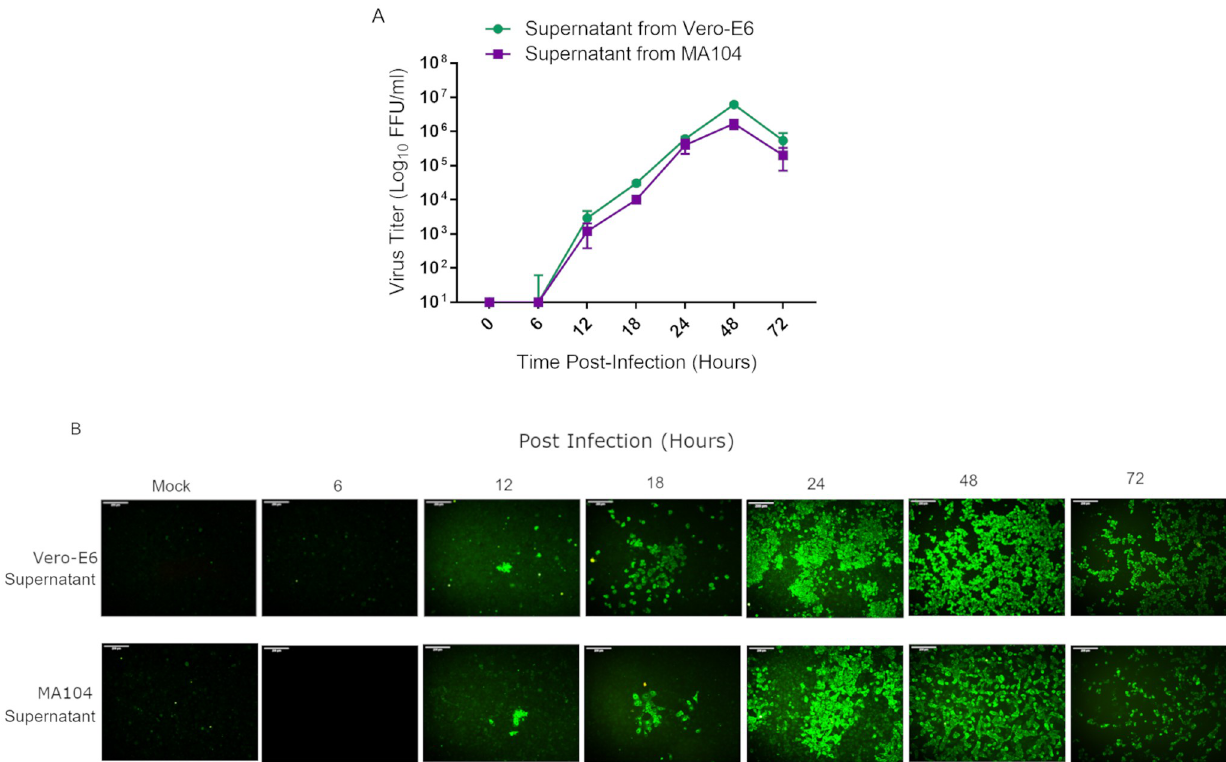
Fig 6. Multi-step growth kinetics of hCoV-19/Turkey/ERAGEM-001/2020. Vero E6 and MA-104 cell lines were infected at an MOI of 0.1. (A) The culture supernatants were harvested from at different time points (6, 12, 18, 24, 48 and 72 h) and stored at -80˚C. The Vero E6 cells were then inoculated with 10-fold serial dilutions of the samples in triplicate per dilution. The virus titers were determined by a focus forming assay (FFA) at the indicated intervals and were assayed in triplicate. The fluorescent foci in each well were counted, and the virus titers were calculated and expressed as fluorescent focus units per ml (FFU/ml). The standard bars represent standard deviations of the mean of the results. (B) The infected cells (Vero E6 supernatant, upper panel, and MA-104 supernatant, lower panel) were stained with the FITC-labeled goat anti-human IgG at the indicated time points and examined under a fluorescence microscope (Leica, DFC450C); for each group, the representative image out of three replicates is shown. Scale bars = 200 μ